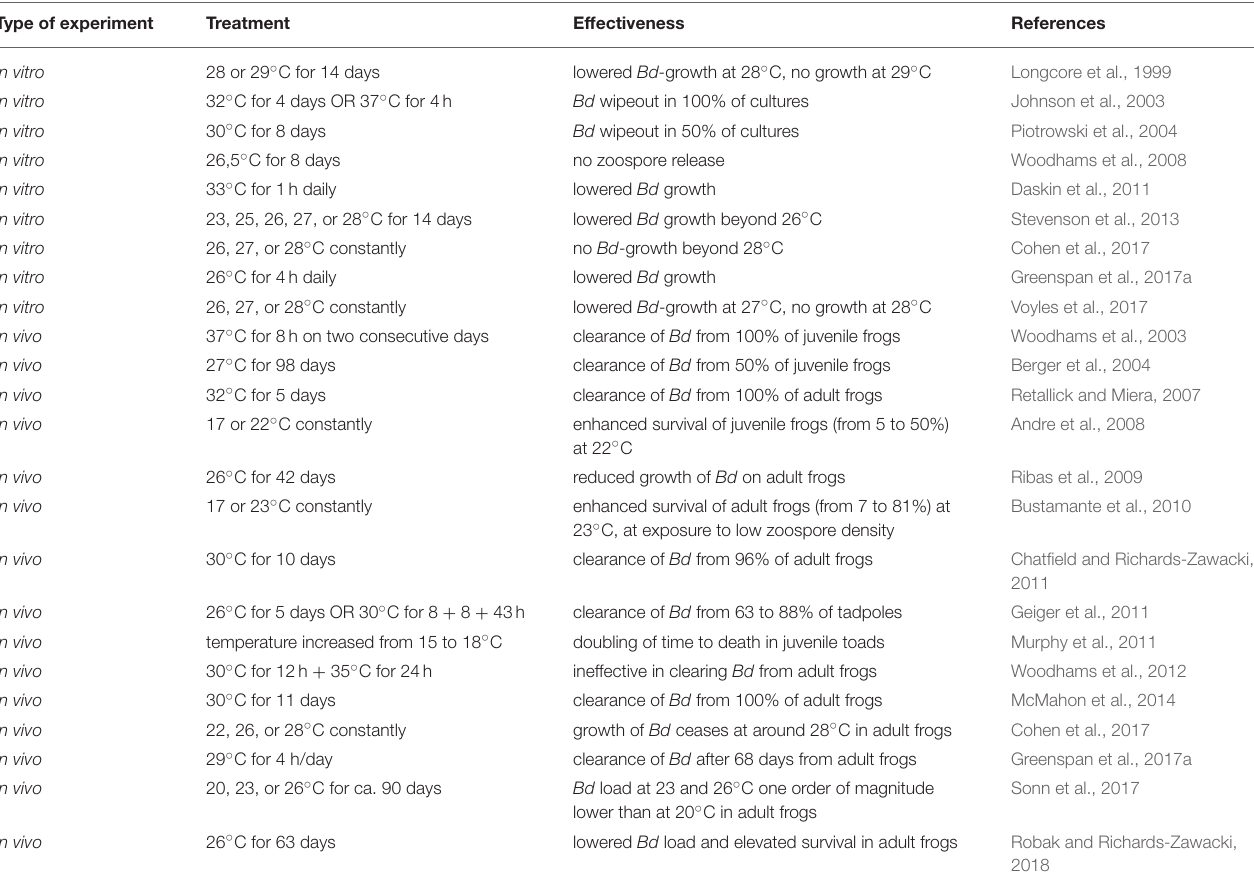
TABLE 1 | The effectiveness of elevated environmental temperature applied against Bd as reported by experiments performed on laboratory cultures of the fungus ( in vitro studies) and on live and infected amphibians ( in vivo experiments). Type of